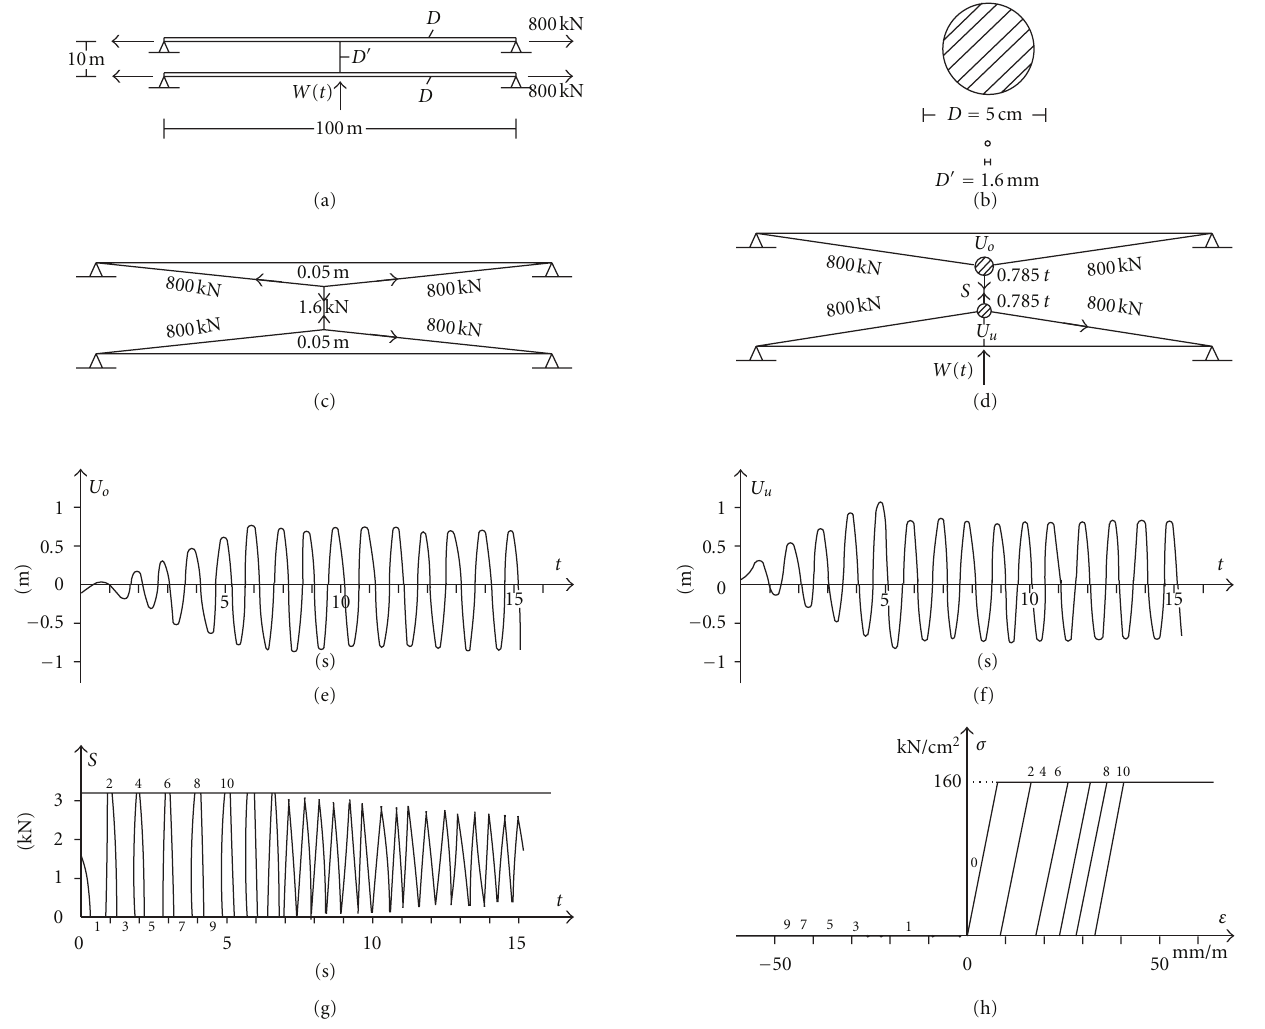
Figure 7: Fifth application: couple of interconnected cables subject to wind. (a) Given geometry and loading. (b) Cross sections of main cables and cross-tie. (c) Initial static analysis. (d) Parameters of dynamic analysis. (e), (f) Resulting time-histories of displacements of two main cables. (g) Resulting time-history of axial force of cross-tie. (h) Resulting hysteresis stress-strain loops of the